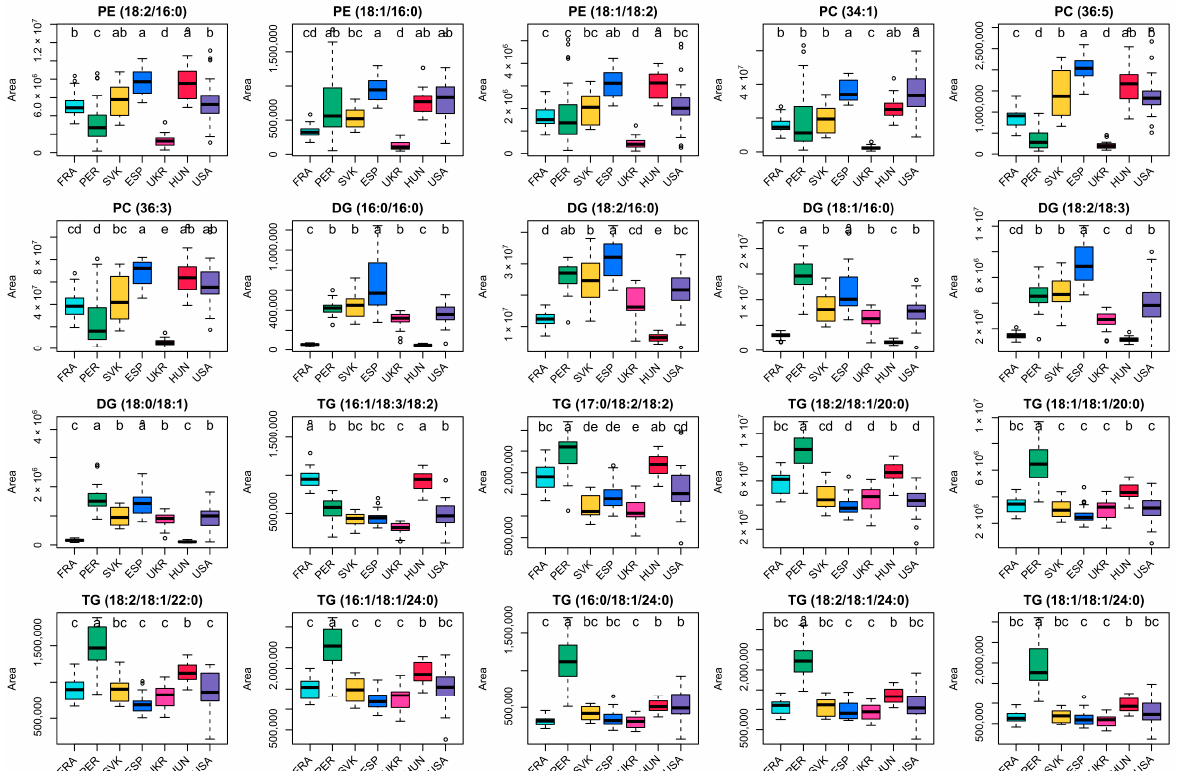
Figure 2. Boxplots of peak areas per sample origin of promising marker substances for the origin verification of grain maize samples. Differences between samples classes are significant ( p -value ≤ 0.01), if labeled with different letters; for all p -values see Figure S3.